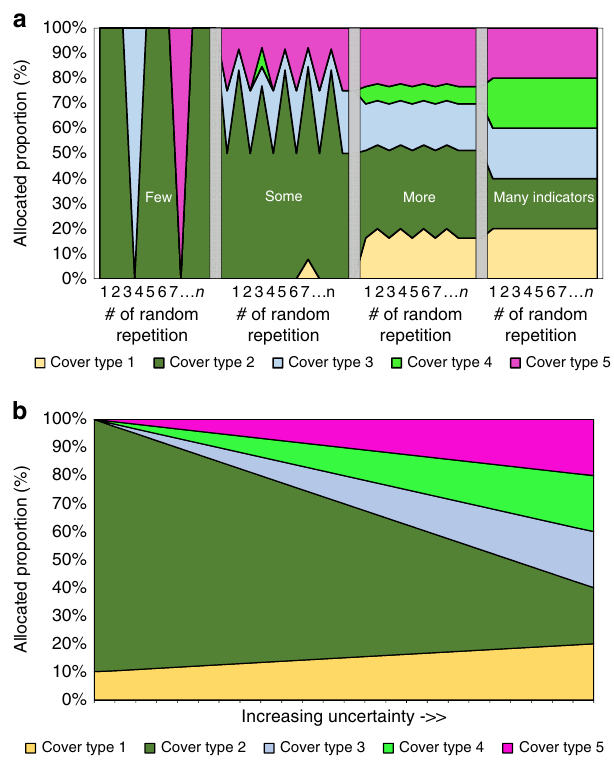
Figure 1 | Schematic overview of theoretically expected